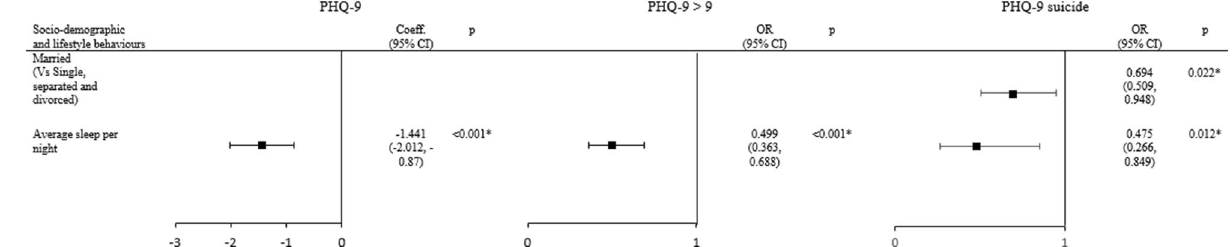
Figure 2. Sociodemographic, professional satisfaction and lifestyle behaviours associated with PHQ-9 score by regression with forward stepwise selection. PHQ-9, Patient Health Questionnaire-9, CI = Confidence Interval; Coeff = Coefficient; OR = Odds Ratio, * Significant with p -value <